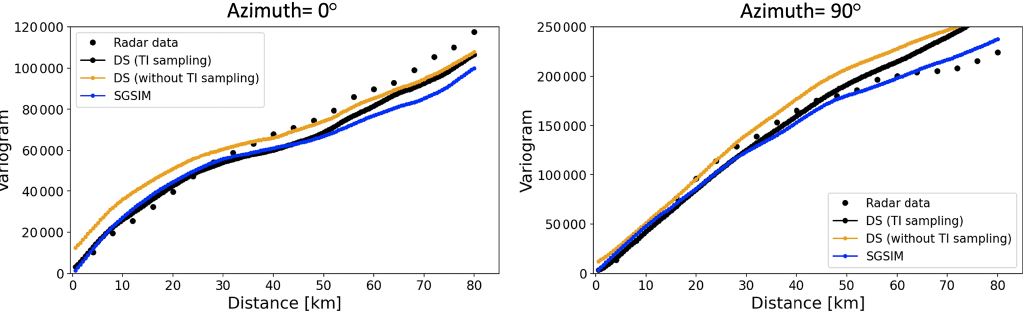
Figure 15. Global variograms of the radar line data and modelled topography